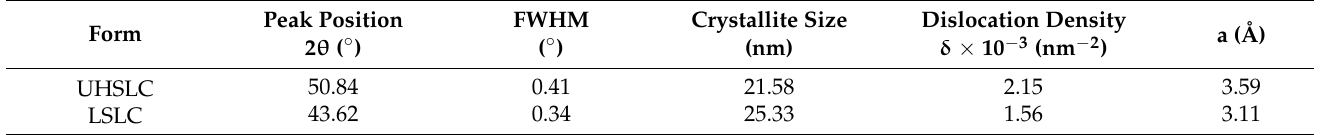
Figure 14. Electrochemical corrosion polarization curve of Inconel625 alloys coatings prepared by UHSLC and LSLC. UHSLC and LSLC. Table 3. Comparison of FWHM, grain size, dislocation density and micro-stress for different remelt- ing